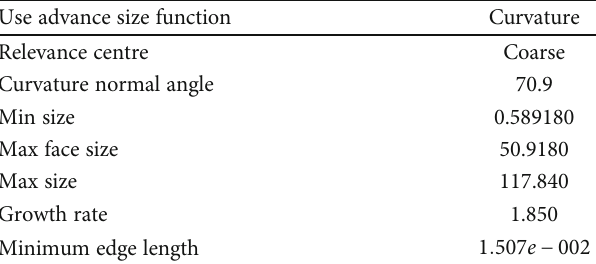
Figure 17: Design-3 (internal view of mesh). Mesh type: unstructured tetrahedral mesh. Nodes: 120561. Elements: 81184. Table 2: The parameters of the grid